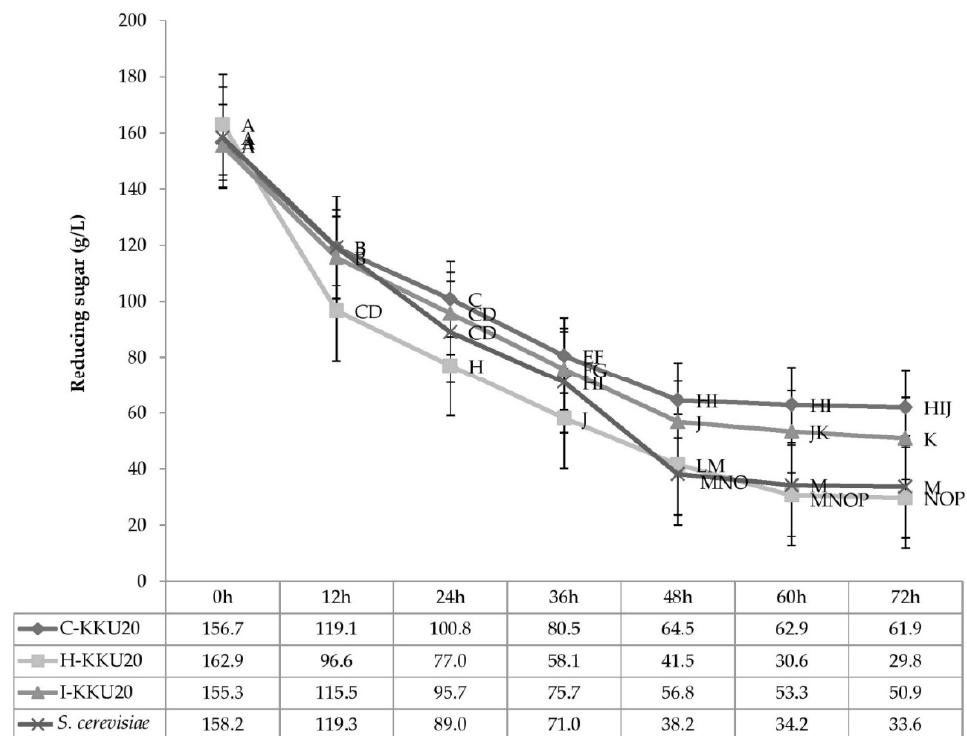
Figure 5. Sugar use by four different yeast strains under sugarcane molasses 25% with urea 1% plus 1% CMC in the incubator shaker at 30 ◦ C and 150 rpm for 72 h. A–P Means with different superscript letters for the interaction effect of time × yeast colonies are significant at p < 0.01. SEM = standard error of the mean, S. cerevisiae = Saccharomyce cerevisiae .